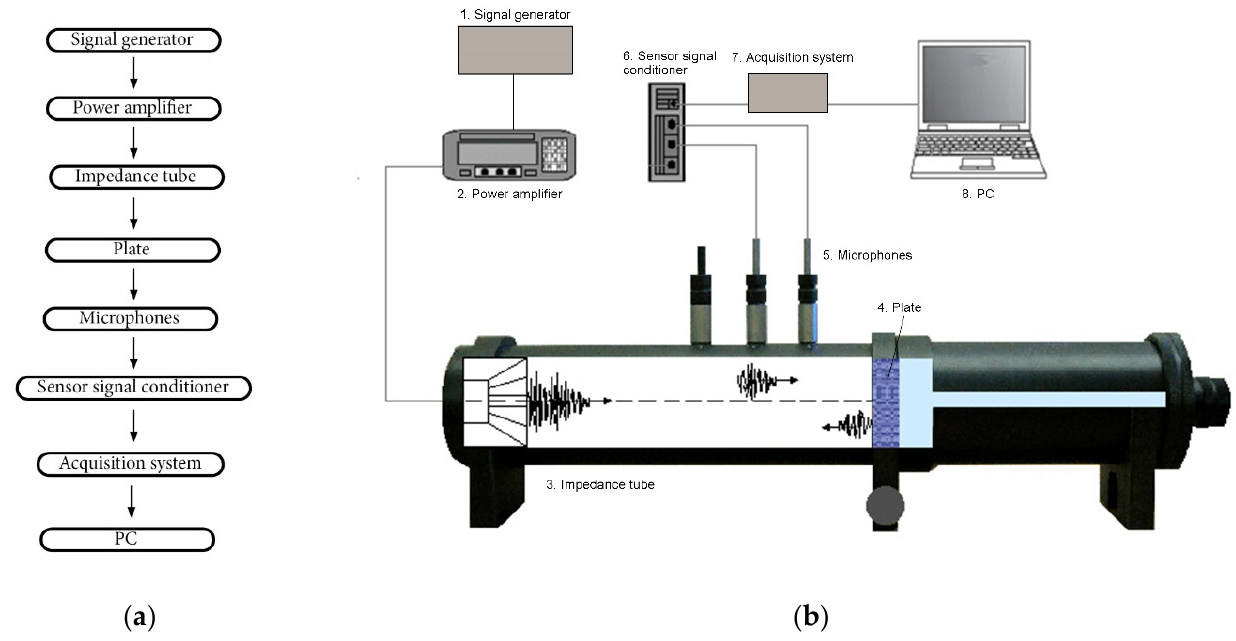
Figure 8. Setup for tests in the passive case: ( a ) scheme and ( b ) instrumentation. Microphones (ICP electret model number 130D21) are used for the impedance tube test. A signal conditioner a PCB 8-channel signal conditioner, series 442B, is adopted for conditioning the sensors and an Audio Power Amplifier Type 2716-C was adopted as a power amplifier. During the tests, the sampling frequency is set to f s = 20,000 Hz and 20 tests are performed, lasting 2 s each. Then, the signals are processed in MATLAB, and the transfer function method is applied to obtain the total, incident and reflected pressure waves in the function of the position inside the tube. Figure 9 plots the reflective behaviour of the plate and as expected, the reflected wave is symmetrical to the incident one. The reflection coefficient is evaluated for different third octave bands from 100 Hz to 2 kHz, and the results are listed in Table 1. Figure 9. Sound pressure reconstructed inside the impedance tube for the passive case at f = 1000 Hz: real part, with acoustic pressure in Pascal in Y axis and tube length in meters in X axis.